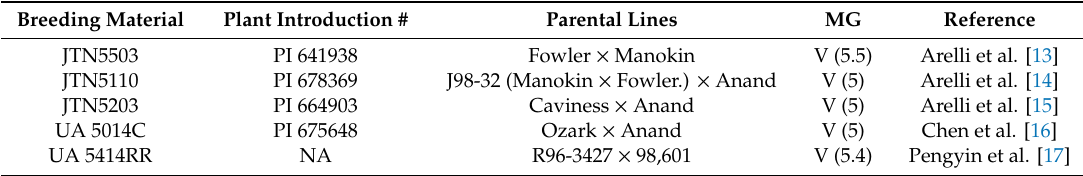
Table 1. List of soybean lines, plant introduction (PI) number, pedigree, maturity group (MG) and year of